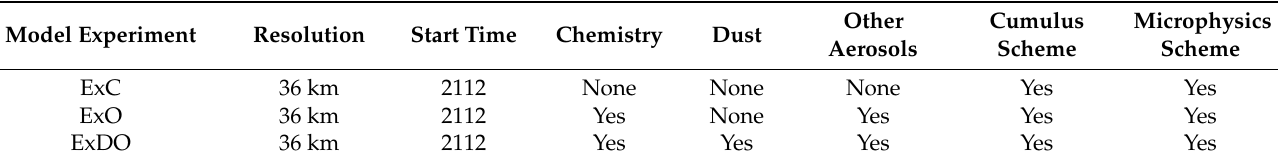
Table 1. The configuration of the simulations. Other aerosols include black carbon, organic carbon, sea salt, and sulfate. The values in the start time column indicate day and hour. For example, 2112 indicates at 1200 UTC on 21 August 2010. Model